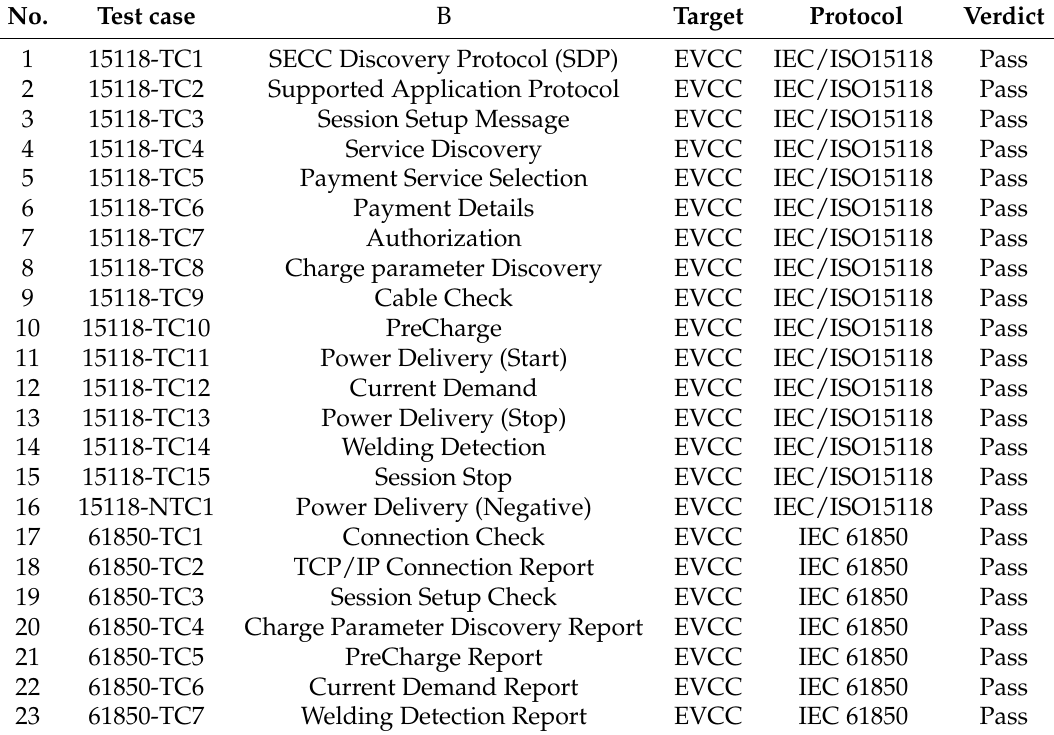
Table 2. Test result of the reference charger with high-level stack and IEC 61850. EVCC, EV Communication